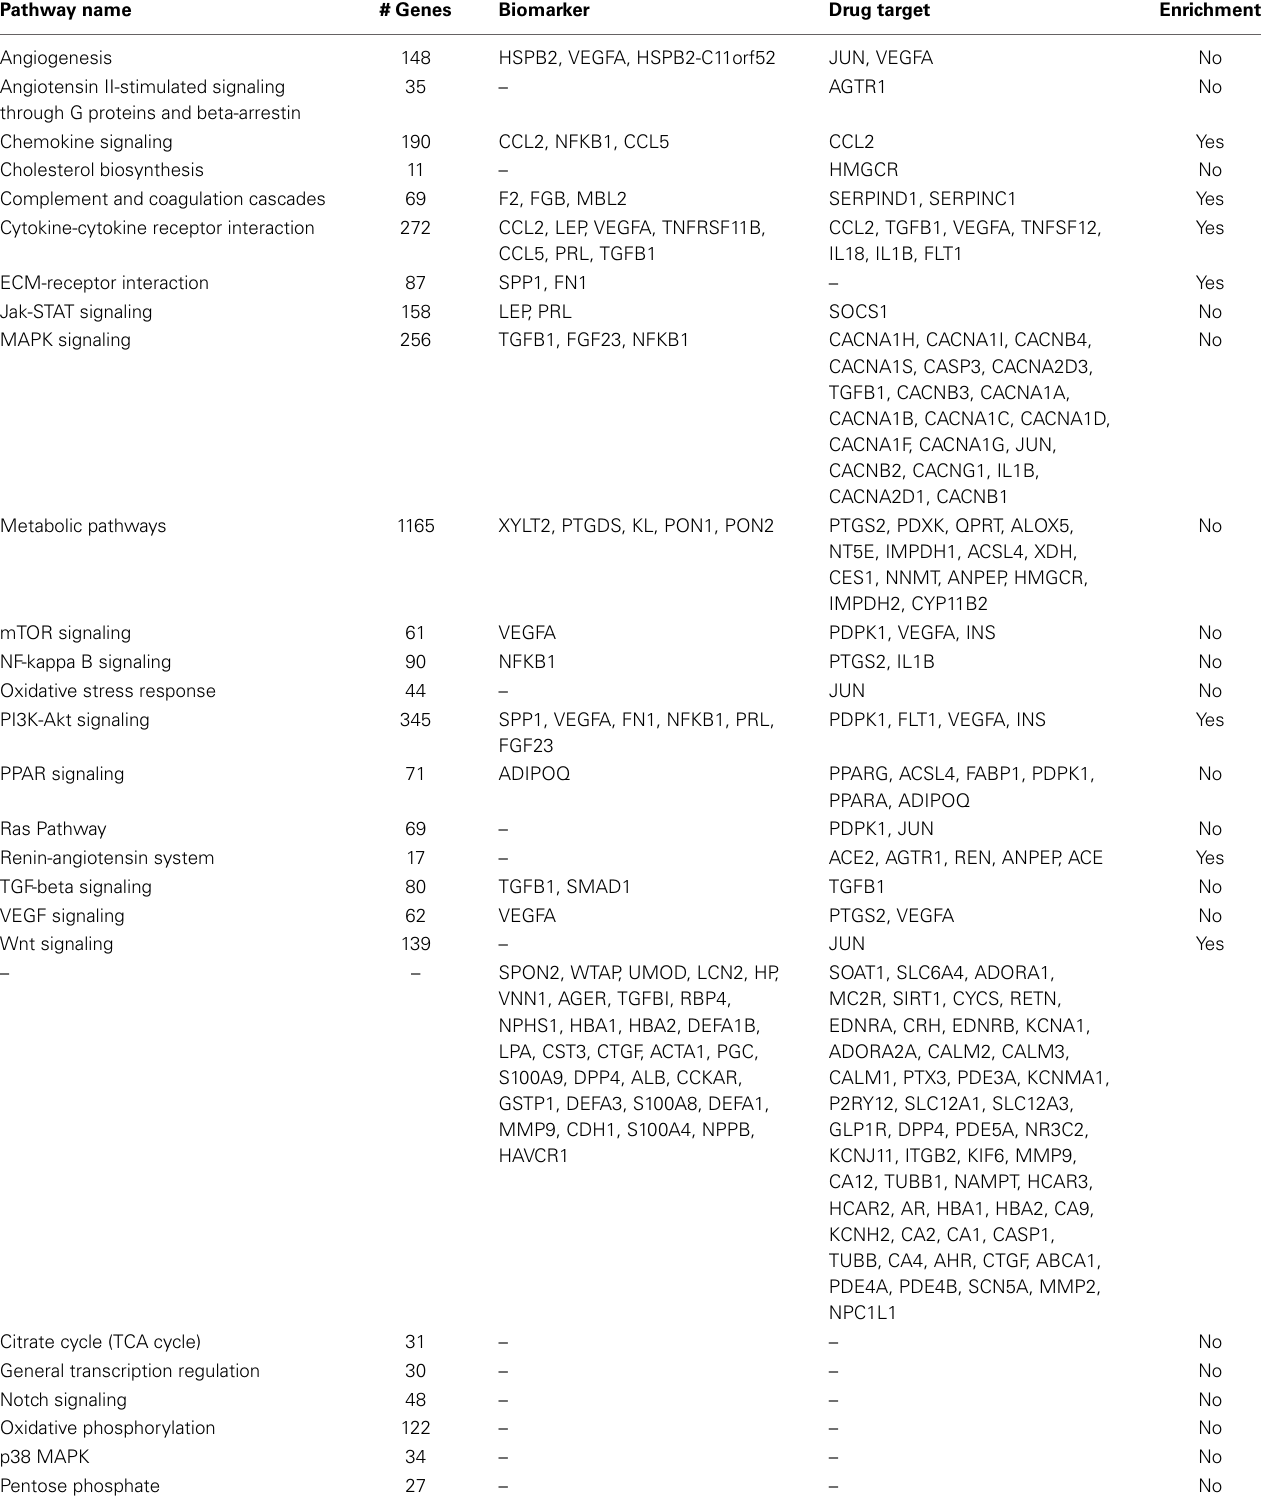
Table 3 | Molecular pathway annotation, diabetic